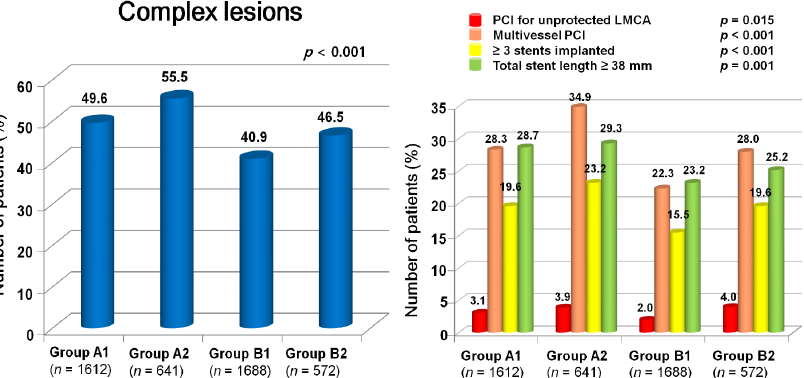
Figure 3. Distribution of complex lesions in the 4 groups. Group A1, ≥ 65 years and early invasive; Group A2, ≥ 65 years and delayed invasive; Group B1, <65 years and early invasive; Group B2, <65 years and delayed invasive, PCI percutaneous coronary intervention, LMCA left main coronary artery.